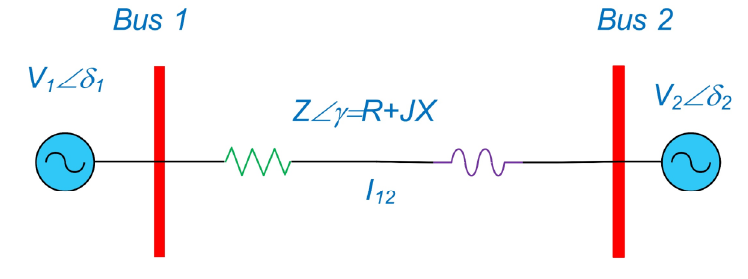
Figure 6. Overview of the connecting two buses.